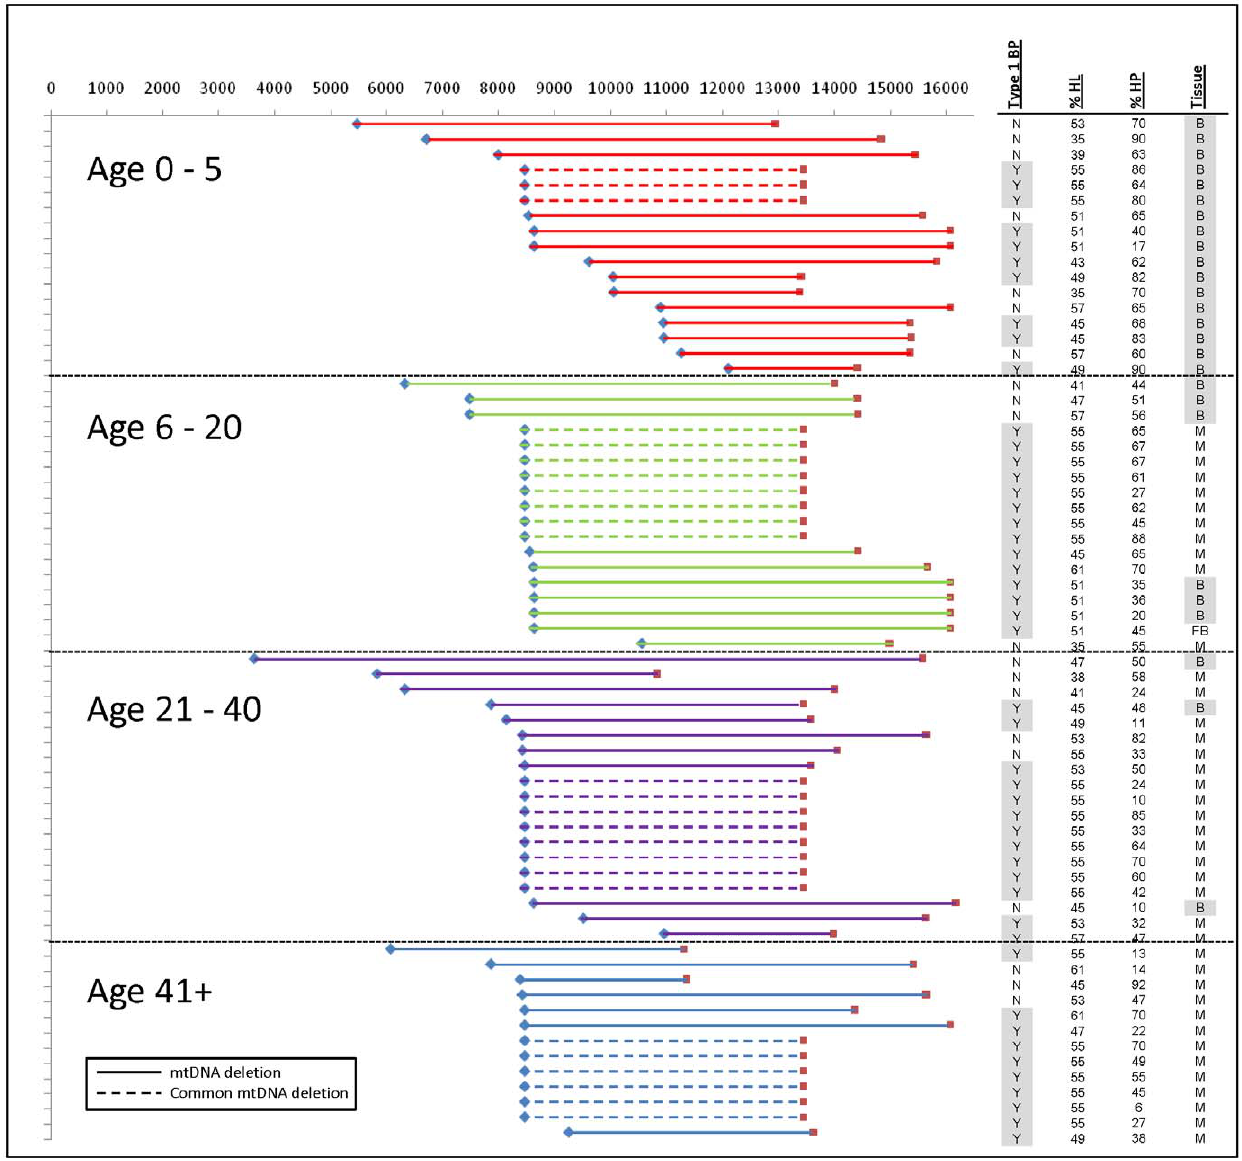
Figure 1. Distribution of deletions in age-grouped mtDNA deletion patients. X-axis represents the nucleotide position along the mitochondrial genome, and y-axis shows deletions for individual patients arranged by the age-group and the most proximity of the left breakpoint to the 1 st nucleotide, from top to bottom. Blue diamonds and red squares represent the left and right breakpoints respectively. Each patient sample has, in the columns on the right, description of the presence of type 1 breakpoint (Type I BP), percent heteroplasmy (% HP), percentage of sequence homology at breakpoints (% HL), and tissue type (Tissue).